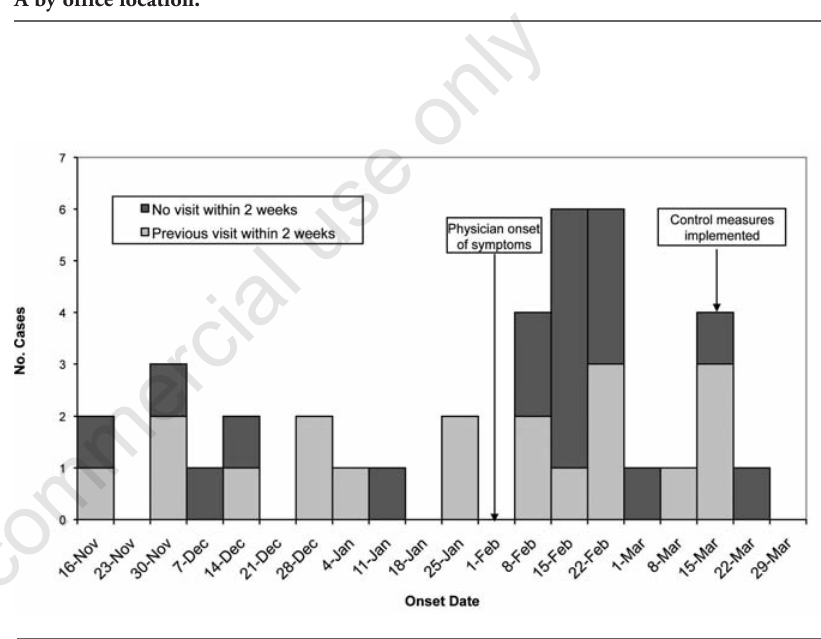
N Figure 2. Epidemiologic curve of epidemic keratoconjunctivitis patients seen at practice A by history of recent office visit.